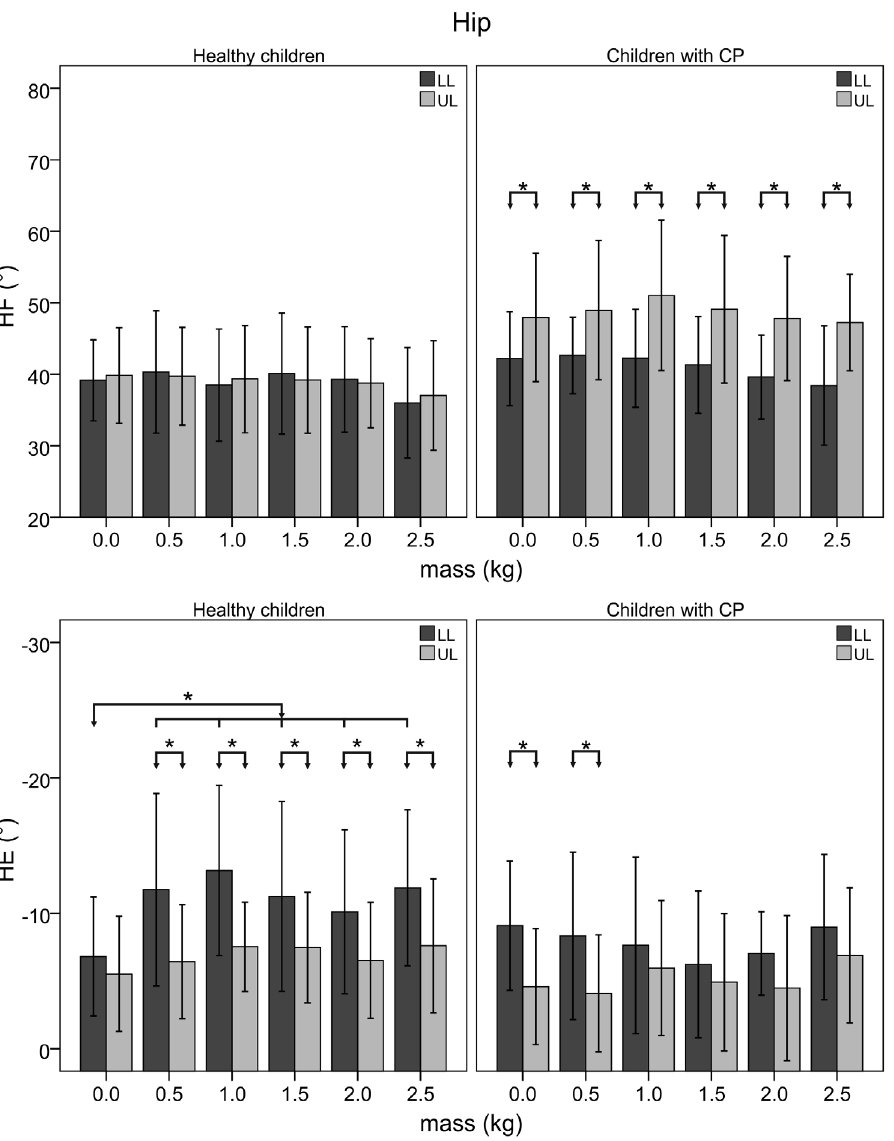
Figure 5. Peaks of hip angle of loaded and unloaded leg. Mean and standard deviation for peak values of hip flexion (HF) and extension (HE) angles of loaded (LL) and unloaded (UL) leg for healthy children and those with CP as a function of the added mass value. Asterisks indicate significant differences.